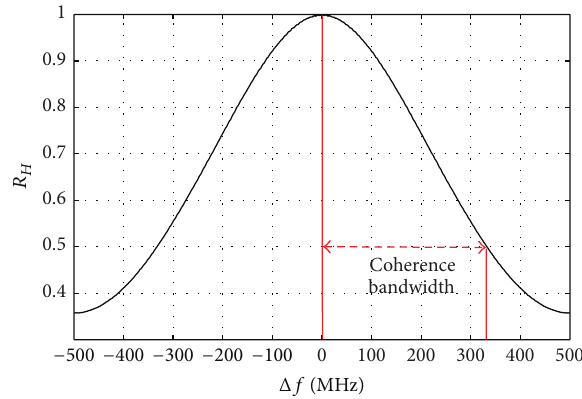
Figure 5: Example plot of frequency correlation function at location 15 of corridor